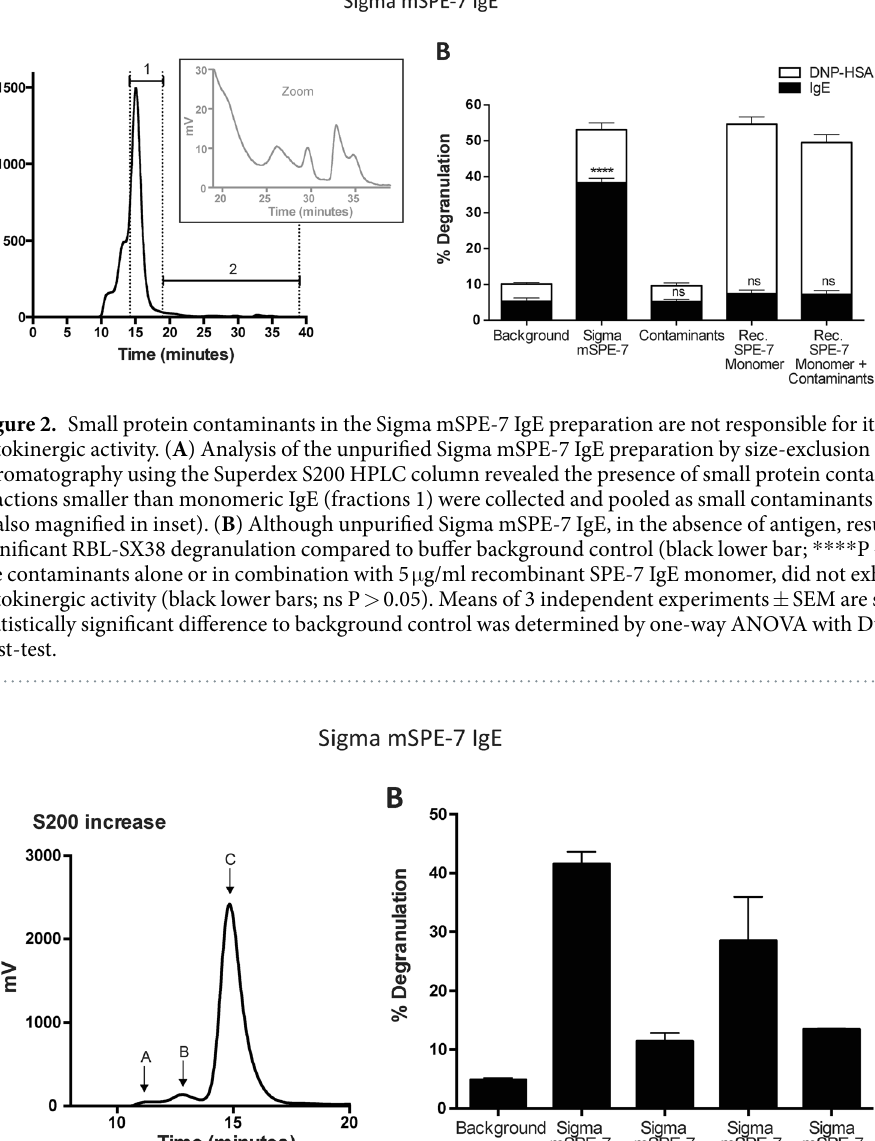
A single antibody preparation, the commercial mouse hybridoma SPE-7 anti-DNP IgE from Sigma, stands at the high-response extreme of the HC group, and causes not only pre-sensitization to antigen activation, but also